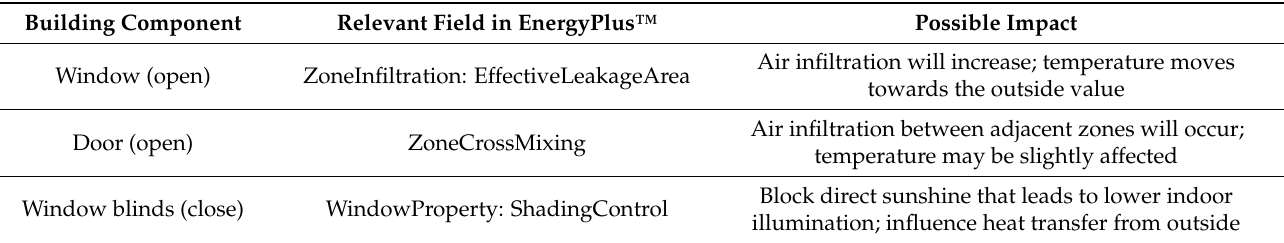
Table 1. Field settings in EnergyPlus™ for modeled